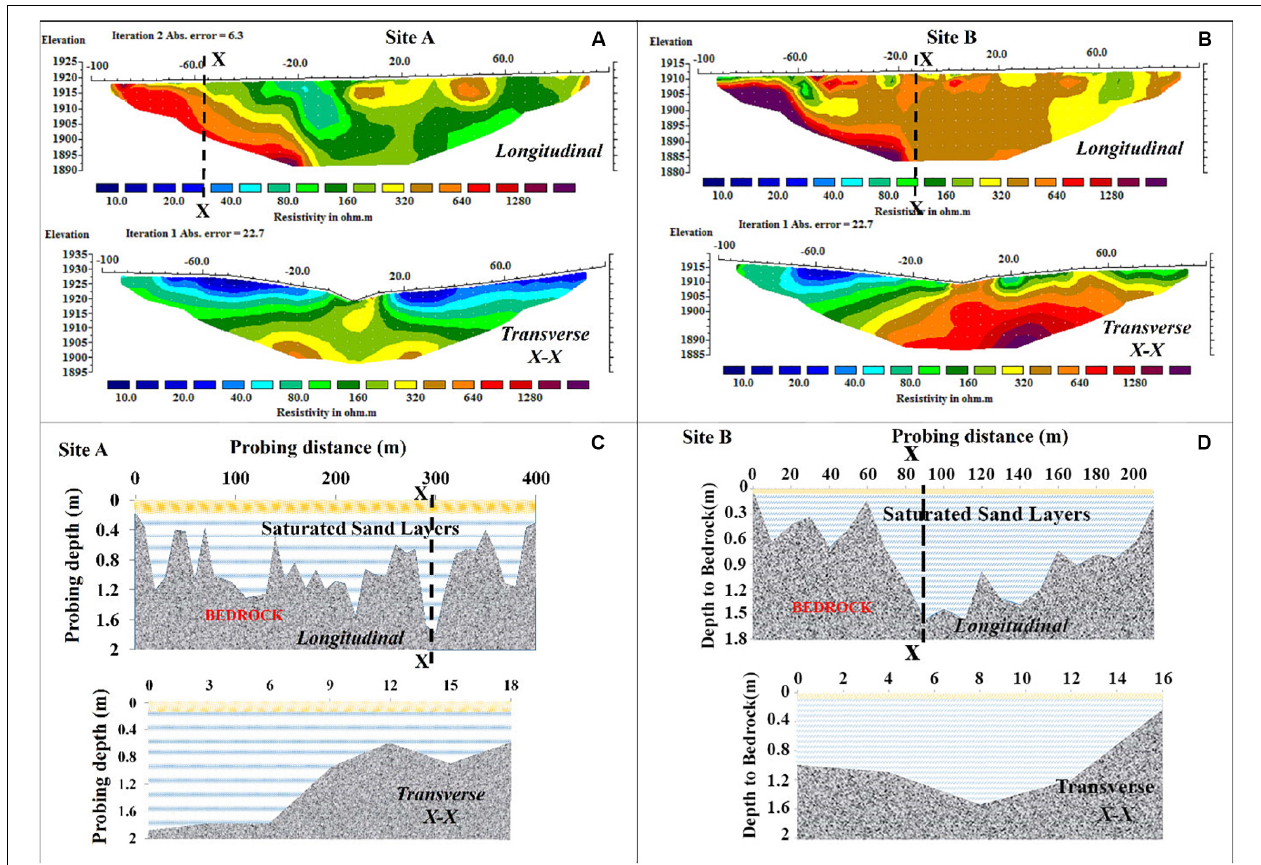
FIGURE 4 | Longitudinal and transverse profiles of resistivity (A,B) and probed bedrock depths (C,D) undertaken at sample sites A and B.